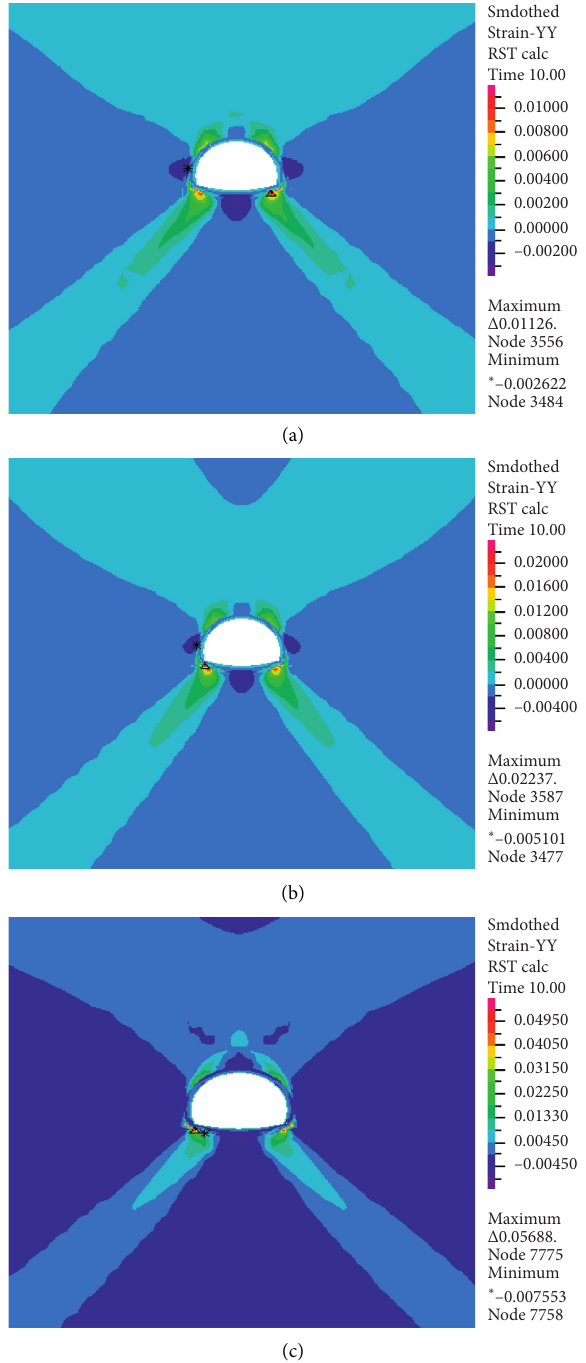
Figure 6: Plastic strain nephograms of the rock surrounding the tunnel with different loess cover thicknesses: (a) 30m, η � 2.251; (b) 60m, η � 2.269; (c) 80m; η �